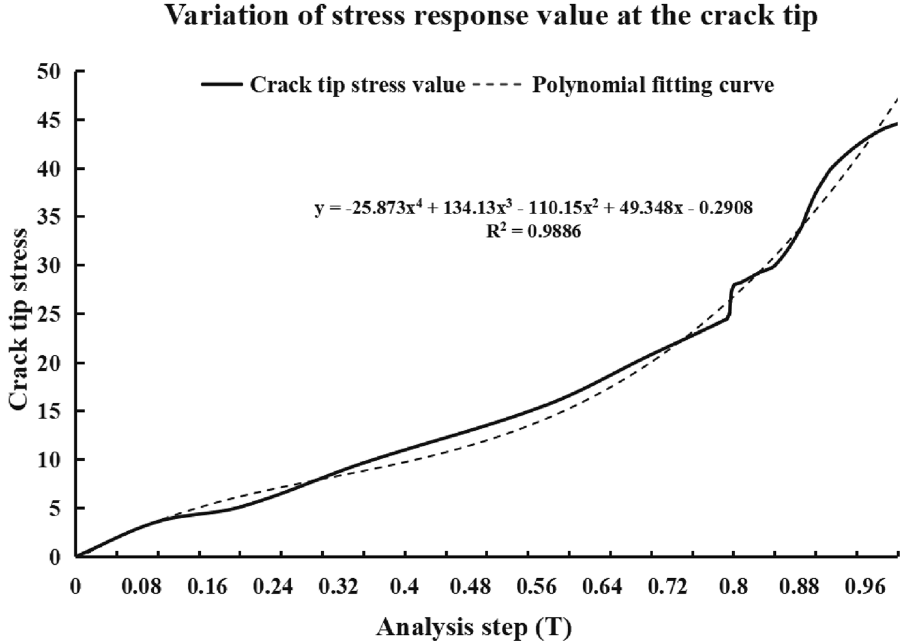
Fig. 7 Stress response phase diagram of the crack tip